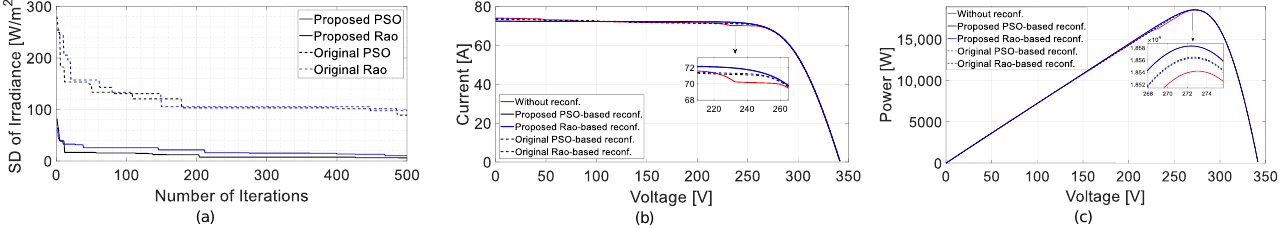
Figure 18. Comparison of characteristics of PV array under the right edge of the cloud. ( a ) Objective function over iterations. ( b ) I-V curves. ( c ) P-V curves.